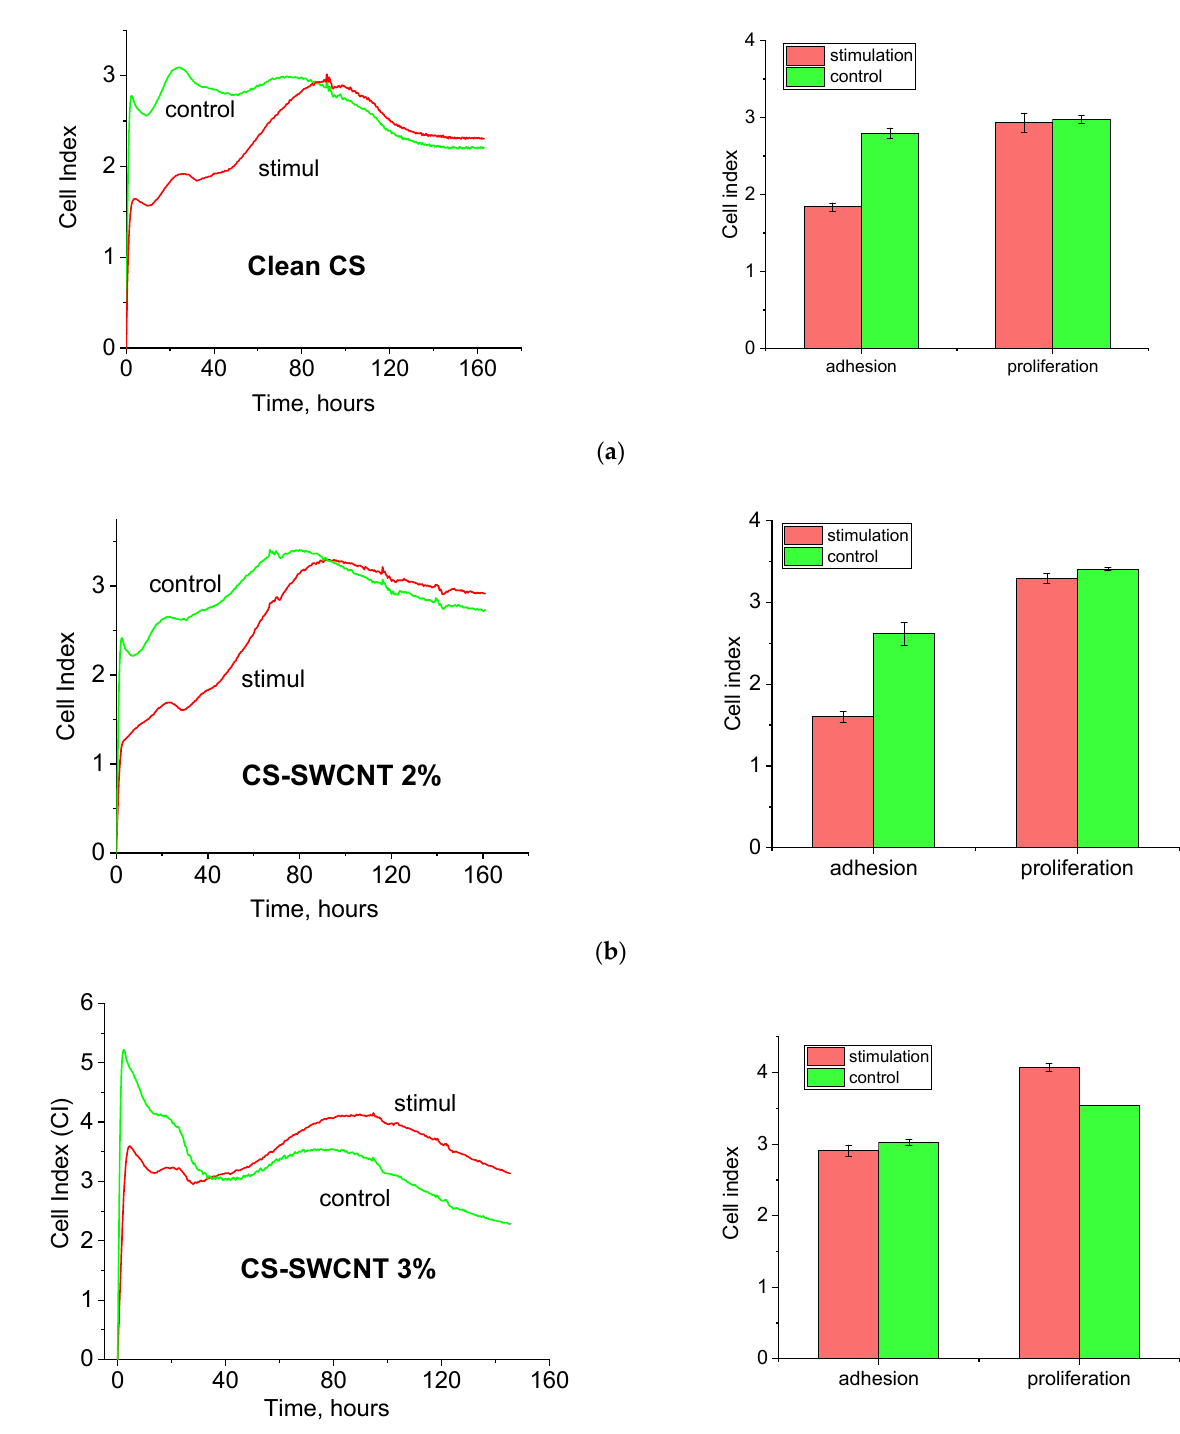
Figure 13. Dependences of the cell index (CI) value on the time of cultivation of human dermal fibroblasts on chitosan-based films containing 0 ( a ), 2.0 ( b ), and 3.0 ( c ) wt.% of SWCNT.